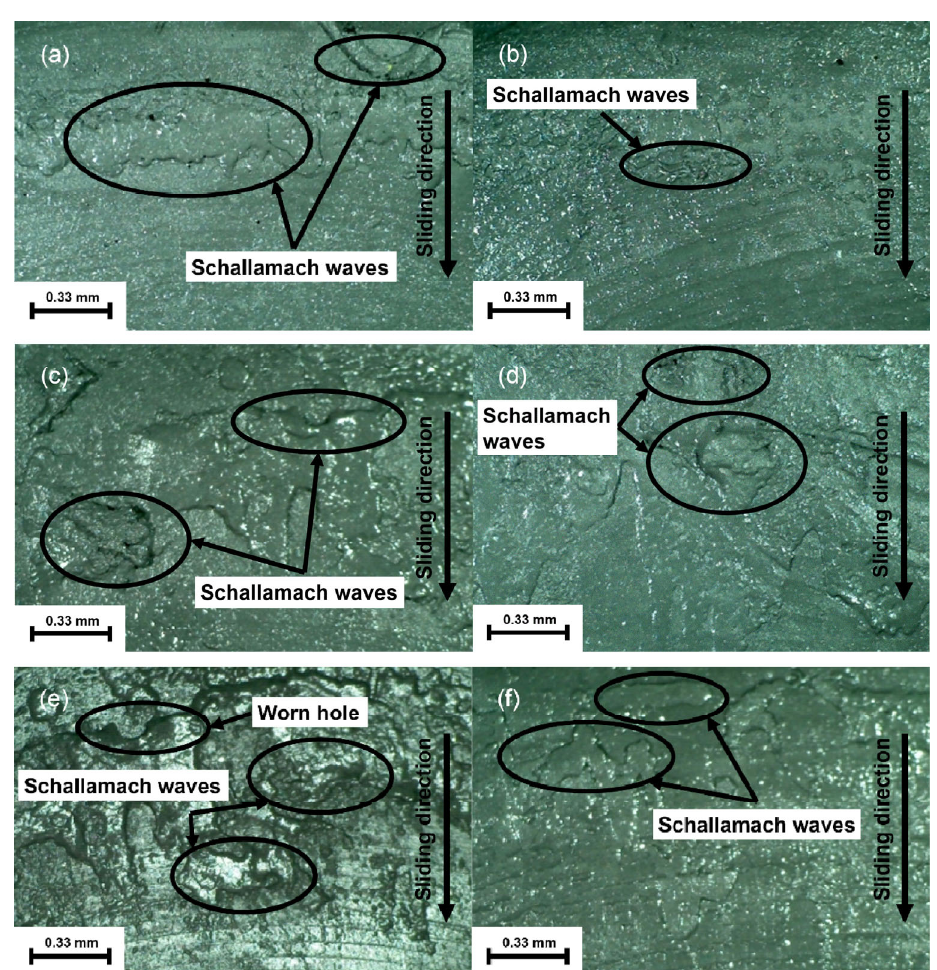
Fig. 9 Surface state images after tests: (a), (b) 10 mm/s, 1 kgf without and with a magnetic field; (c), (d) 1 mm/s, 1 kgf without and with a magnetic field; (e), (f) 1 mm/s, 1.2 kgf without and with a magnetic